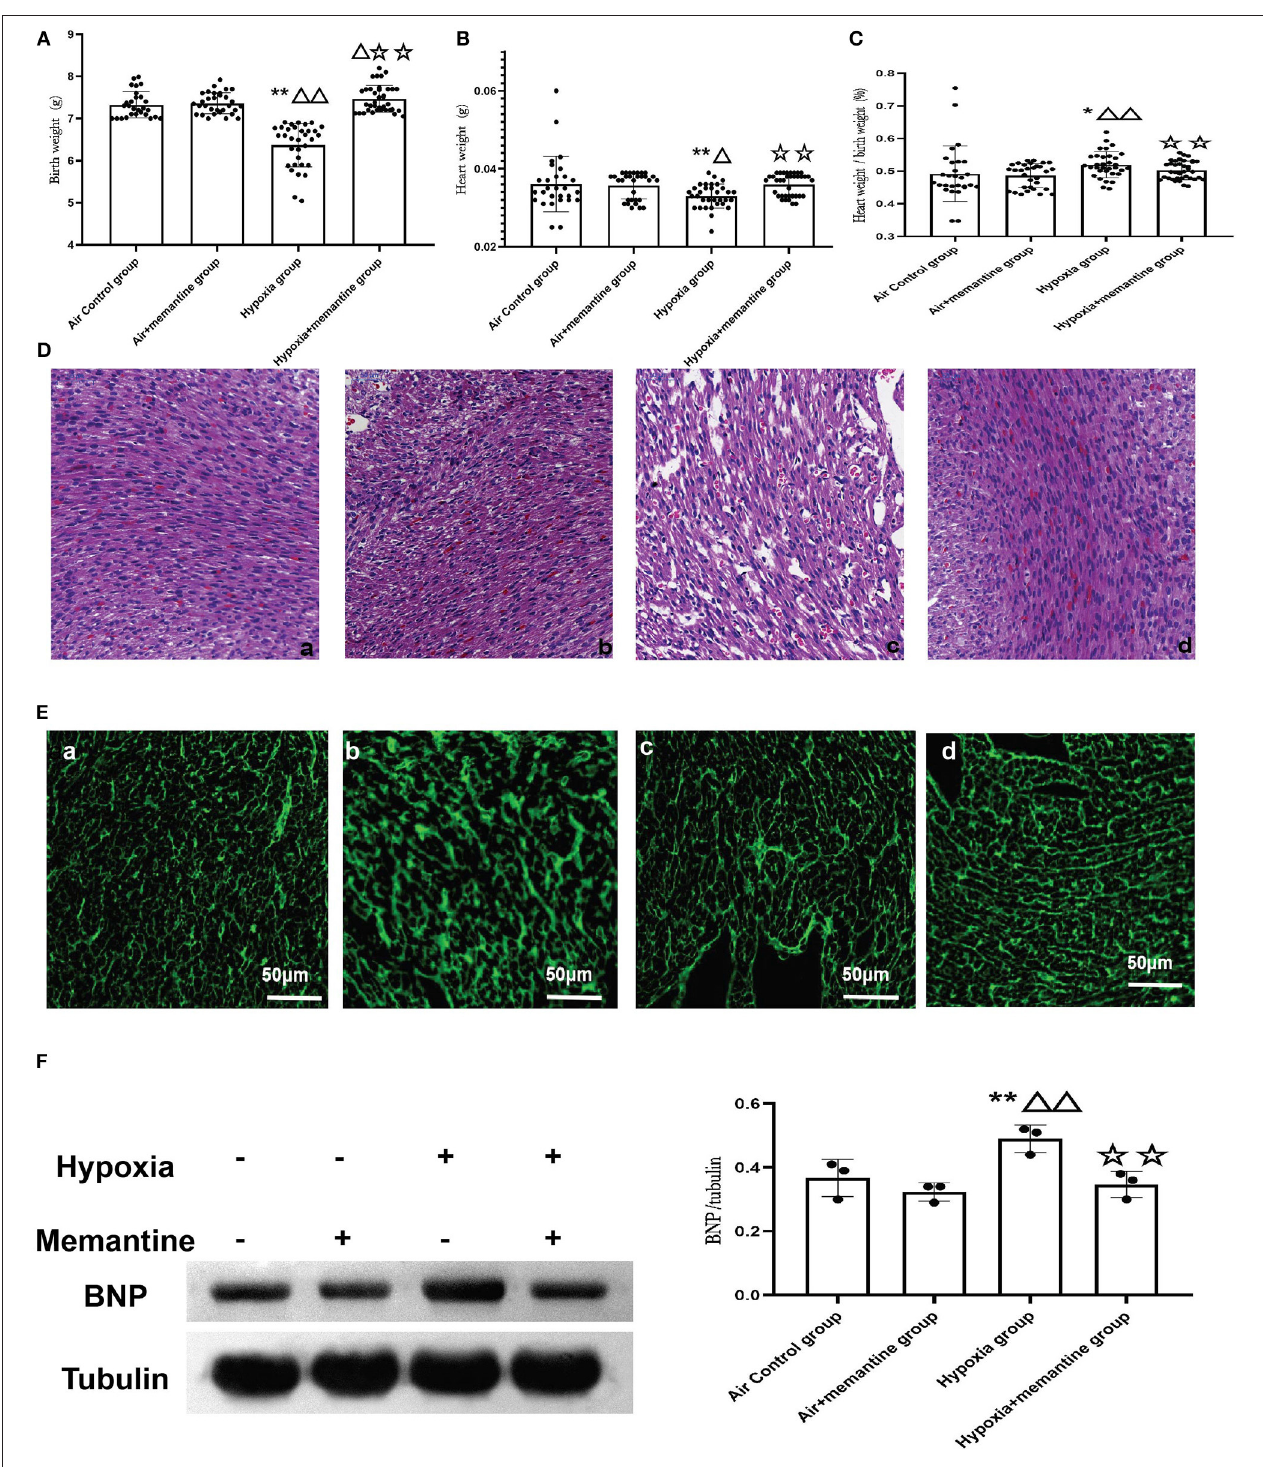
FIGURE 3 | (A–D) Antenatal memantine treatment improved low rat birth weight (A) , heart weight (B) and decreased the ratio of heart weight/ birth weight (C) induced by intrauterine hypoxia. (D) Representative images of HE staining (200x). (a): air control group; (b): air + memantine group; (c): hypoxia group; (d): hypoxia + memantine group. (E) Representative images of WGA staining (400x). (a): air control group; (b): air + memantine group; (c): hypoxia group; (d): hypoxia + memantine group. (F) The representative western blot images of BNP (a) and semi-quantified level of BNP (b). Compared with the air control group: * P < 0.05, ** P < 0.01; compared with the air + memantine group: △ P < 0.05, △△ P < 0.01; compared with the hypoxia group: P P < 0.05, PP P < 0.01. N = 28 for air control group; N = 31 for air + memantine group; N = 33 for hypoxia group; N = 37 for hypoxia + memantine group.